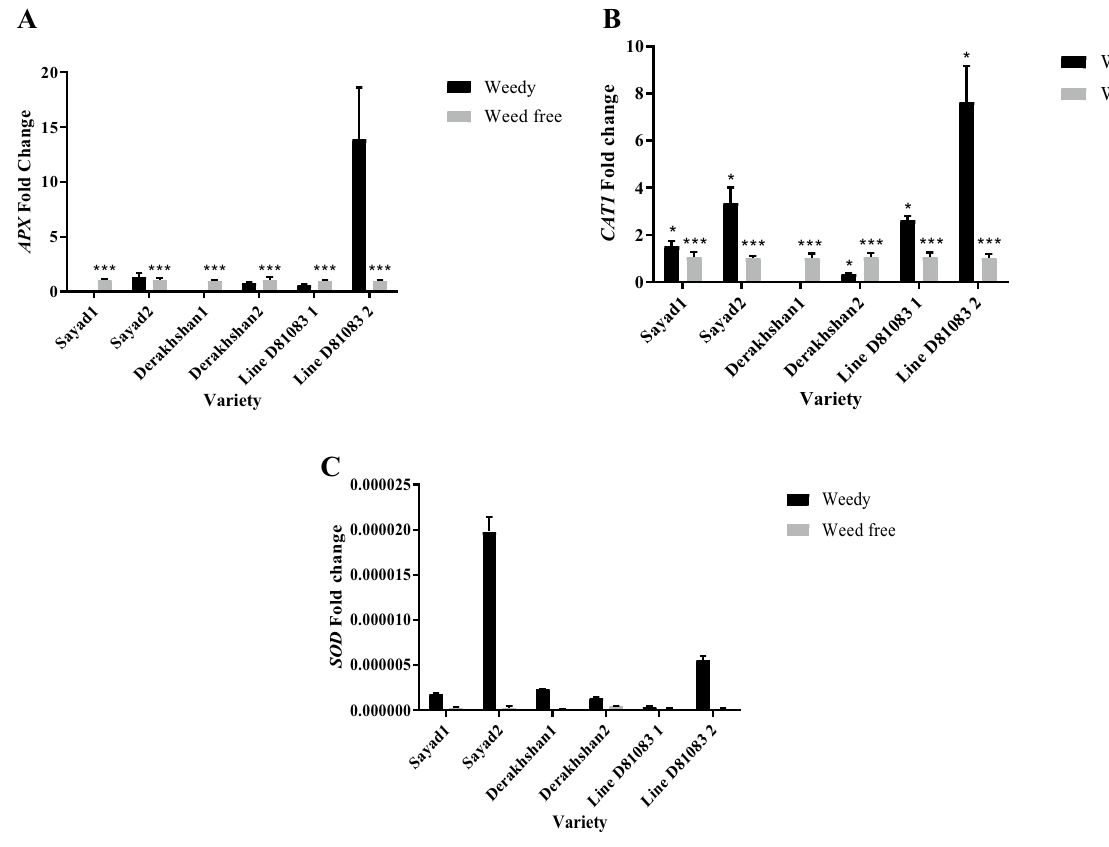
Figure 1. Real-time PCR (qRT-PCR) analysis of transcription levels of APX ( A ), CAT1 ( B ) and SOD ( C ) genes in two treatments: weedy and weed free, in the three cultivars/lines studied in two stages of sampling V4 and R7 (data are the mean ± standard error in five biological replications and five technical replications, numbers 1 and 2 next to the name of the cultivar represent the V4 and R7 stages, respectively). ***: P < 0.99; *: P < 0.90. shan cultivar (0.024 times). The highest and lowest CAB gene expression was reported in the R7 stage in Sayad and Derakhshan cultivars (showing an increase by 0.90 and 0.19) respectively (Fig. 2). Evaluation of PHYB ( Phytochrome B ) gene expression in weedy and weed-free conditions in the V4 stage (Fig. 3) showed that the expression of this gene was higher under complete weed interference in Sayad cultivar (2.38 times) as compared with the weed-controlled state. It was, however, lower in Derakhshan cultivar and line